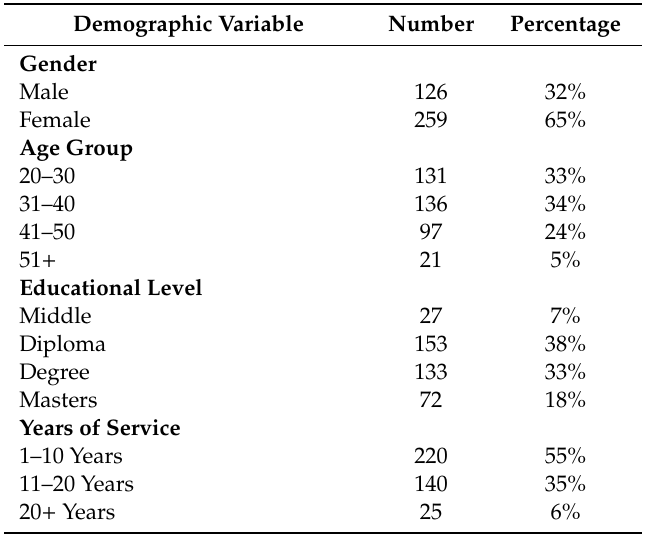
Table 2. Characteristics of the respondents of the study ( n =